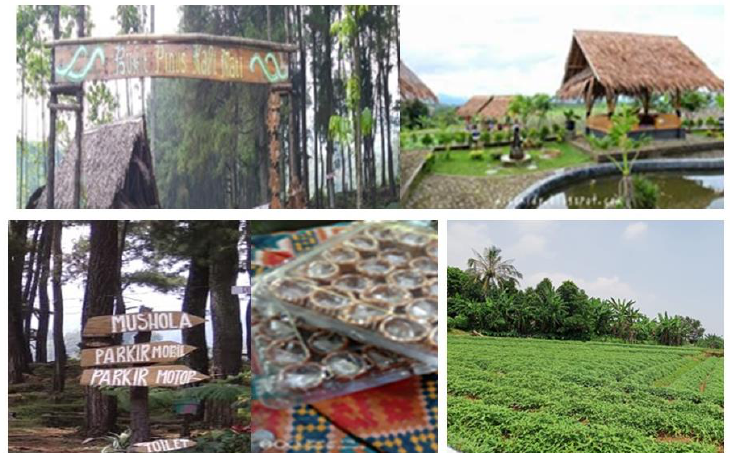
Figure 2 . Tourism Potential of Sukajadi Village: Kali Mati Pine Forest, De Saung Restaurant, signages, Ginger Nougat Snack, Cassava plantation